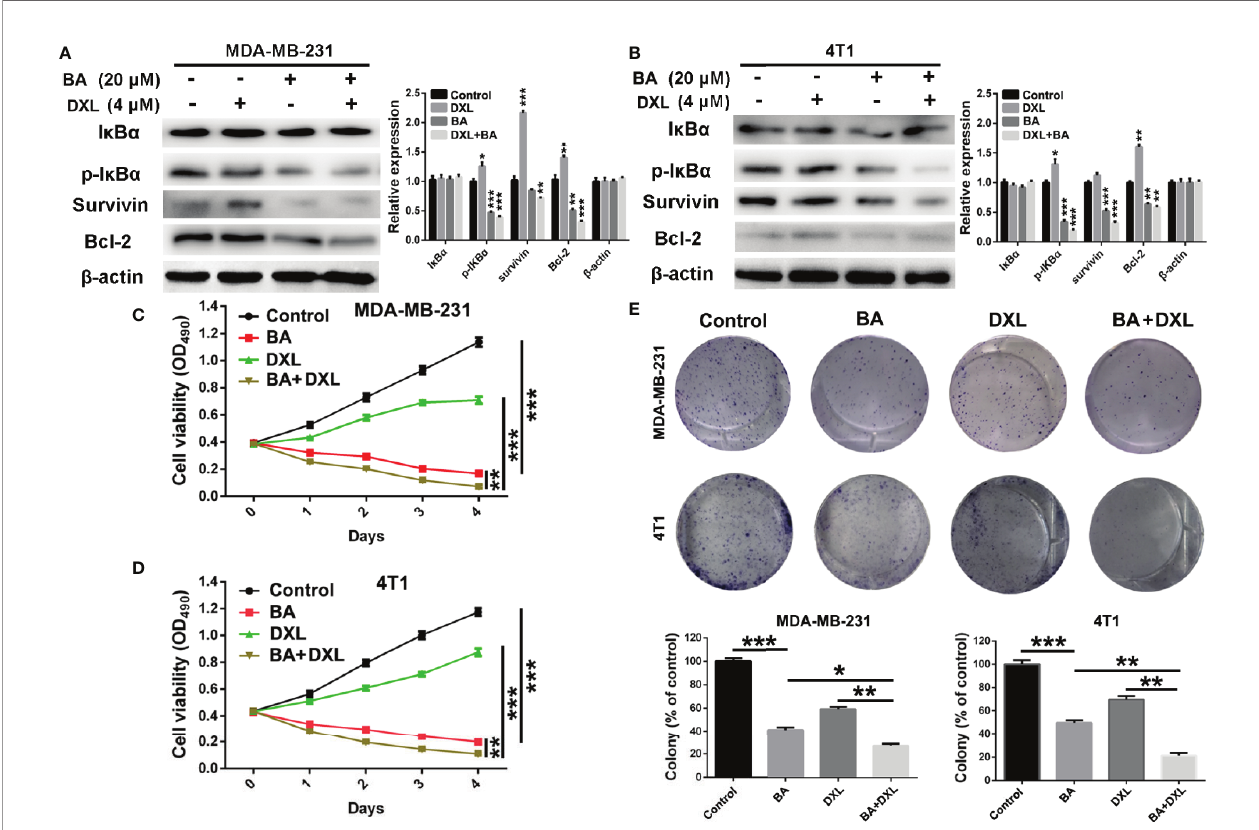
FIGURE 4 | BA sensitized breast cancer cells to docetaxel (DXL) by suppressing NF- k B signaling pathway. (A, B) Western-blot analysis of expression levels of apoptotic proteins in MDA-MB-231 and 4T1 cells after treatment with BA (20 m M) and/or DXL (4 m M) for 48 h. (C, D) Cell viabilities of MDA-MB-231 and 4T1 were assessed after treated with BA (20 m M) and/or DXL (4 m M) for different times (0, 1, 2, 3, and 4 days). (E) Cell proliferations of MDA-MB-231 and 4T1 were evaluated after different treatments. Signi fi cant differences are indicated as follows: * P < 0.05; ** P < 0.01; *** P <